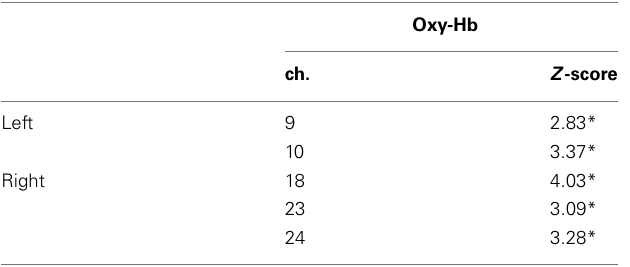
Table 1 | Channels activated in the different-face condition (Experiment 1) compared to the baseline.